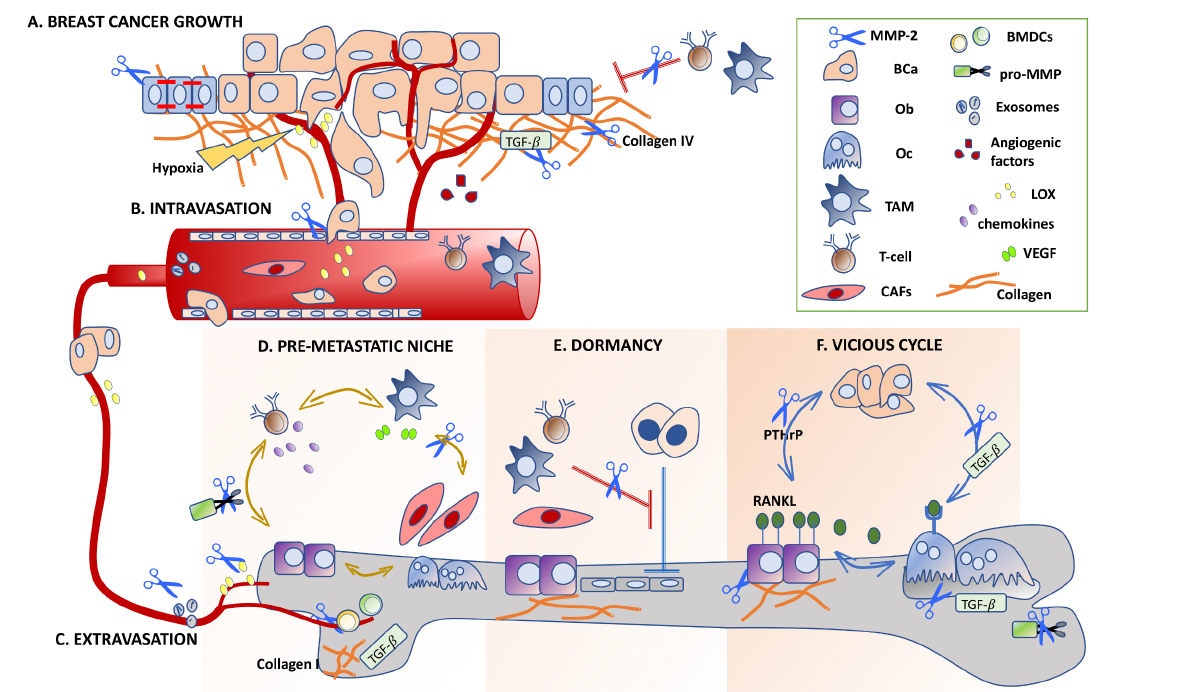
Figure 1. Roles for matrix metalloproteinase-2 (MMP-2) in the breast-to-bone metastatic cascade. ( A ) MMP-2 contributes to breast cancer growth and immune evasion by regulating the availability of growth factors, including TGF β . ( B , C ) Extracellular matrix (ECM) degradation is critical for intravasation/extravasation into/out of the blood vessels, and MMP-2 is capable of processing several ECM components, including type I collagen, to facilitate these processes. ( D ) MMP-2 activity in the pre-metastatic niches of the bone promotes ECM remodeling of the niche and the recruitment of stromal and immune cells that in turn facilitate the recruitment of disseminated breast cancer cells. ( E ) New evidence shows that TGF β isoforms are important mediators of dormancy entry/exit, and MMP-2 regulation of the TGF β isoform bioavailability may play an important role in these processes. ( F ) MMP-2 is capable of controlling the activity and bioavailability of several growth factors important in the breast cancer cell, osteoblast, and osteoclast vicious cycle. Inset illustrates the major cellular players and factors involved. Breast cancer, Ob: osteoblasts; Oc: osteoclasts; TAM: tumor-associated macrophage; CAF: cancer-associated fibroblasts; BCa; BMDCs: bone-marrow-derived